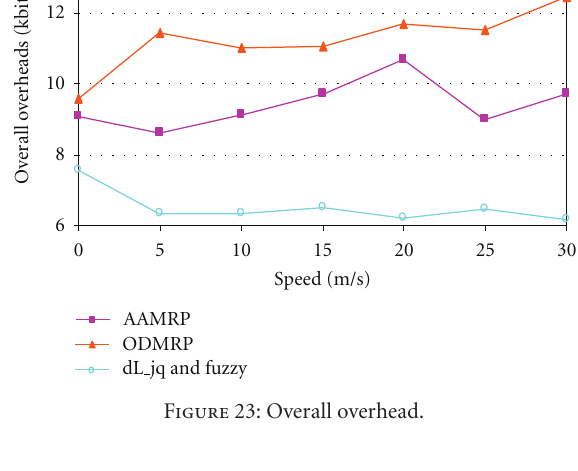
Figure 23: Overall